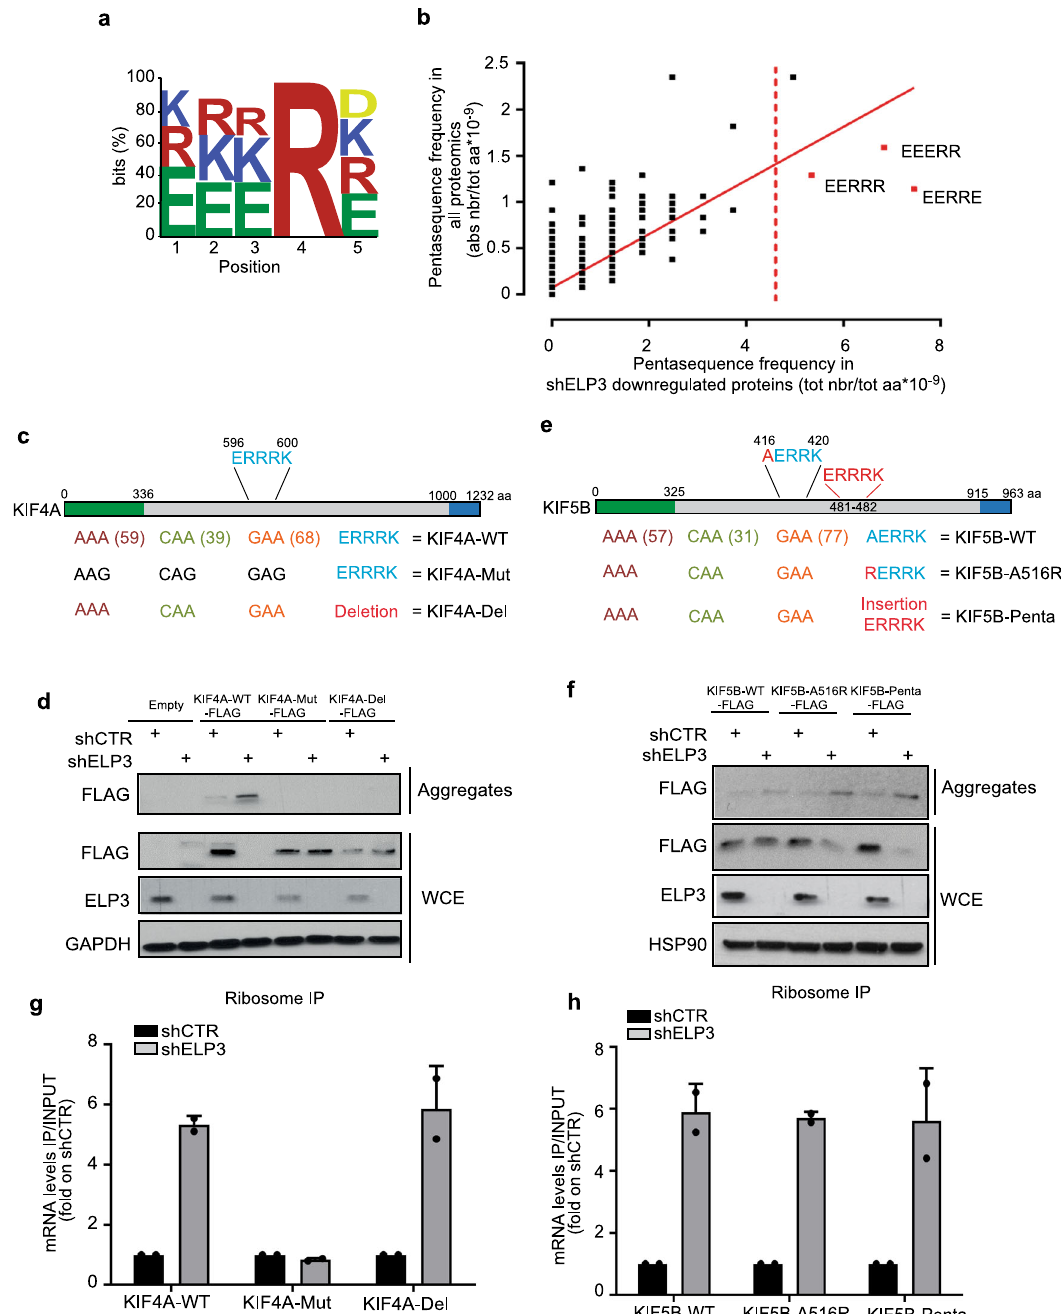
Fig. 5 Speci fi c hydrophilic motifs dictate protein aggregation upon loss of U 34 -enzymes. a Identi fi ed hydrophilic motif. b Assessment of the speci fi c hydrophilic pentasequences (in red) overrepresented in proteins downregulated upon ELP3 depletion. Linear regression is plotted. c , e Schematic representation of KIF4A ( c ) and KIF5B ( e ) proteins and mutants. Hydrophilic motifs are indicated. The kinesin domain (green) and the globular region (blue) of the proteins are indicated. d , f Levels of indicated proteins were determined by western blot in whole-cell extract (WCE) and aggregates of MCF7 cells overexpressing the indicated mutants of KIF4A ( d ) and KIF5B ( f ) and depleted of ELP3 ( n = 2 replicates). g , h qRT-PCR after ribosome immunoprecipitation of KIF4A ( g ) and KIF5B ( h ) mutants. n = 2 independent experiments, data are mean + ( χ 2 test: p = 9.84 × 10 − 48 ; Supplementary Data 4). Furthermore, the motif discriminates proteins that are downregulated ( χ 2 test: p = 3.88 × 10 − 18 ; Fig. 5b) and directed into aggregates upon ELP3